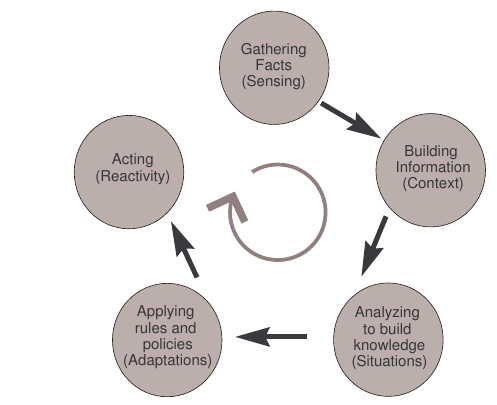
Figure 1. Context-aware systems’ execution